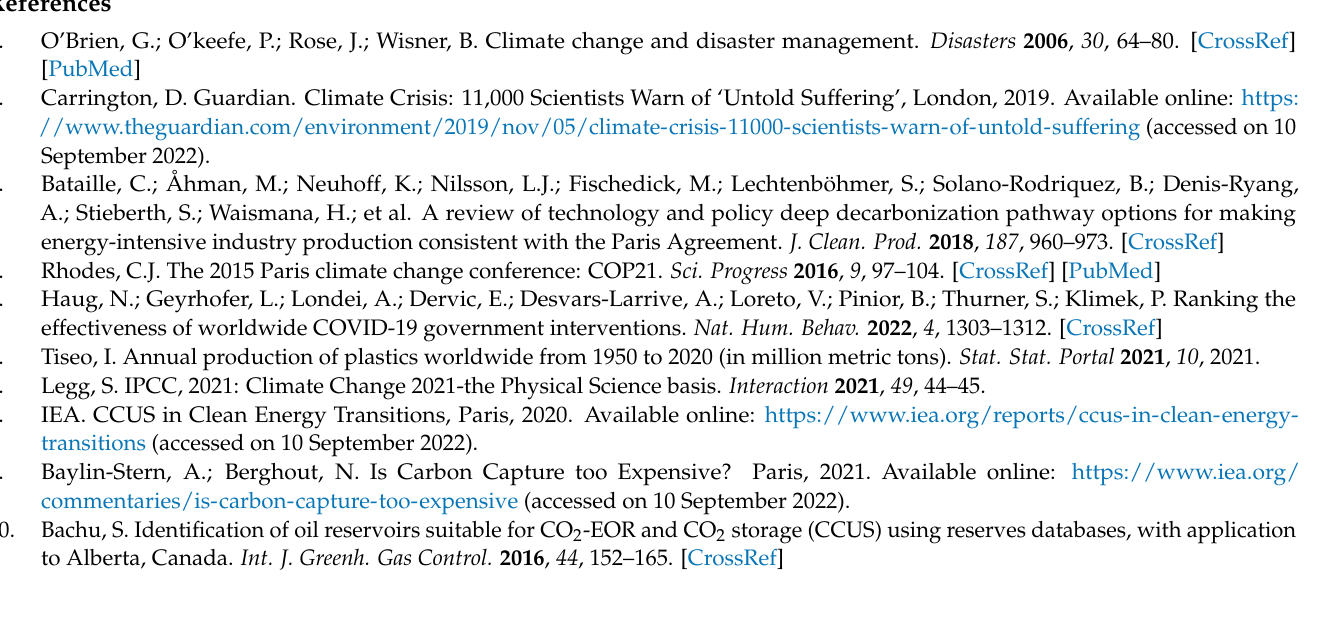
Table S11. CO 2 absorption rate of 10 wt.% AMP over operation time. [Unit of CO 2 absorption rate: g · CO 2 /kg · Absorbent s − 1 ]. Table S12. CO 2 absorption rate of 5 wt.% AMP over operation time. [Unit of CO 2 absorption rate: g · CO 2 /kg · Absorbent s − 1